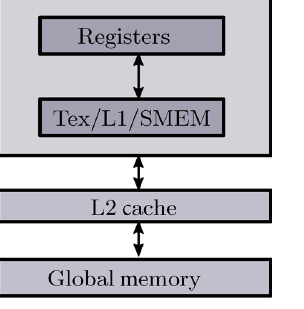
Fig. 4 Example memory hierarchy of an nVidia